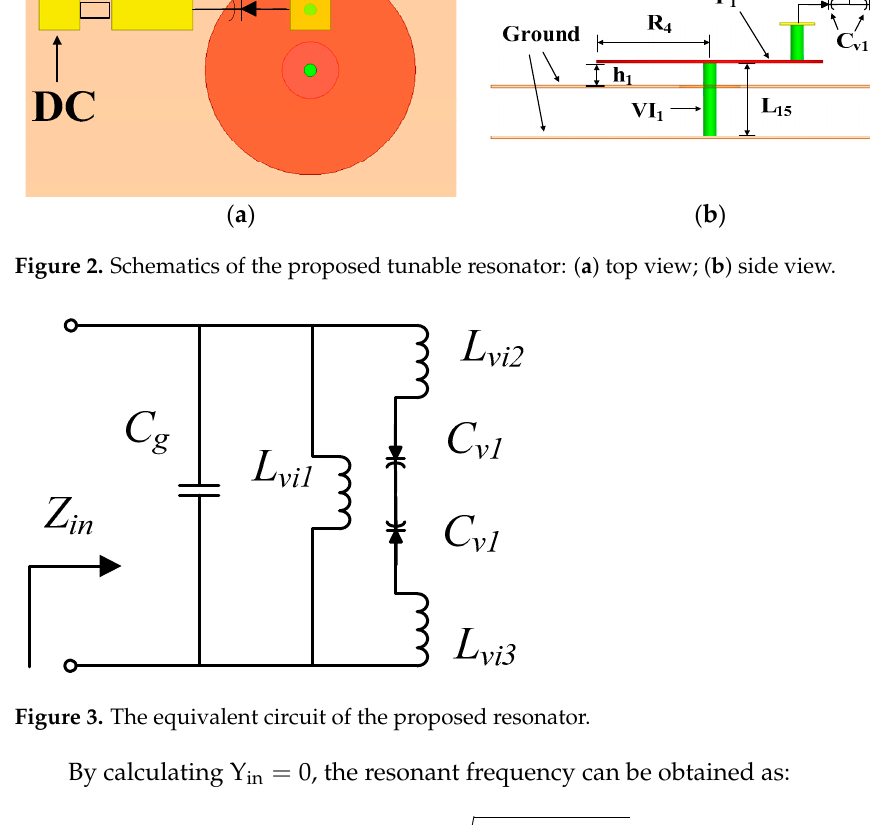
Figure 2. Schematics of the proposed tunable resonator: ( a ) top view; ( b ) side view.